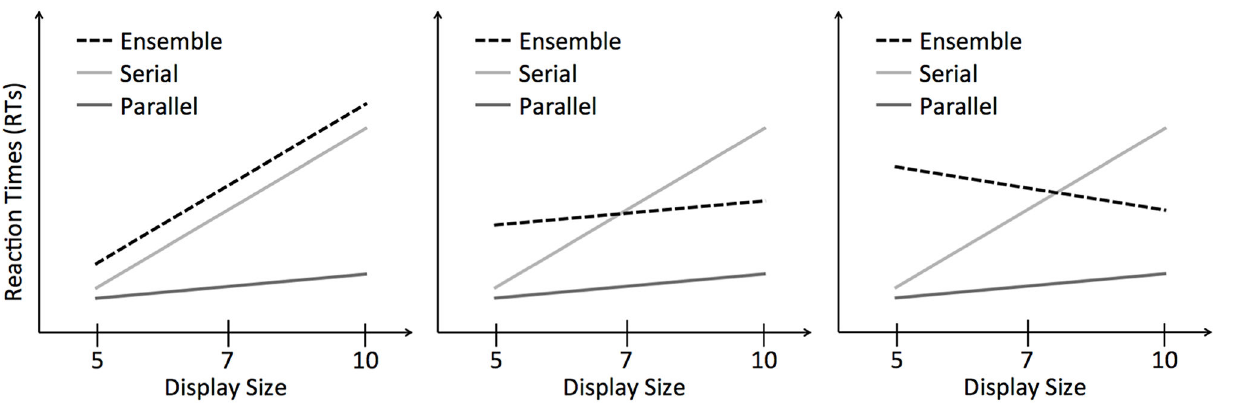
Figure 1. Predictions for Experiment 1. Note. For serial search (light gray), RTs are expected to increase with increasing display size, and for parallel search (dark gray), RTs typically remain flat or increase only slightly with increasing display size (all panels). The ensemble task (dashed black lines) may give rise to a RT pattern similar to that of either the serial search (left panel) or parallel search (middle panel) tasks, depending on whether numerical meaning is extracted from multiple items serially or in parallel. Alternatively, faster RTs with increasing display size (right panel) would suggest a contribution of ensemble coding